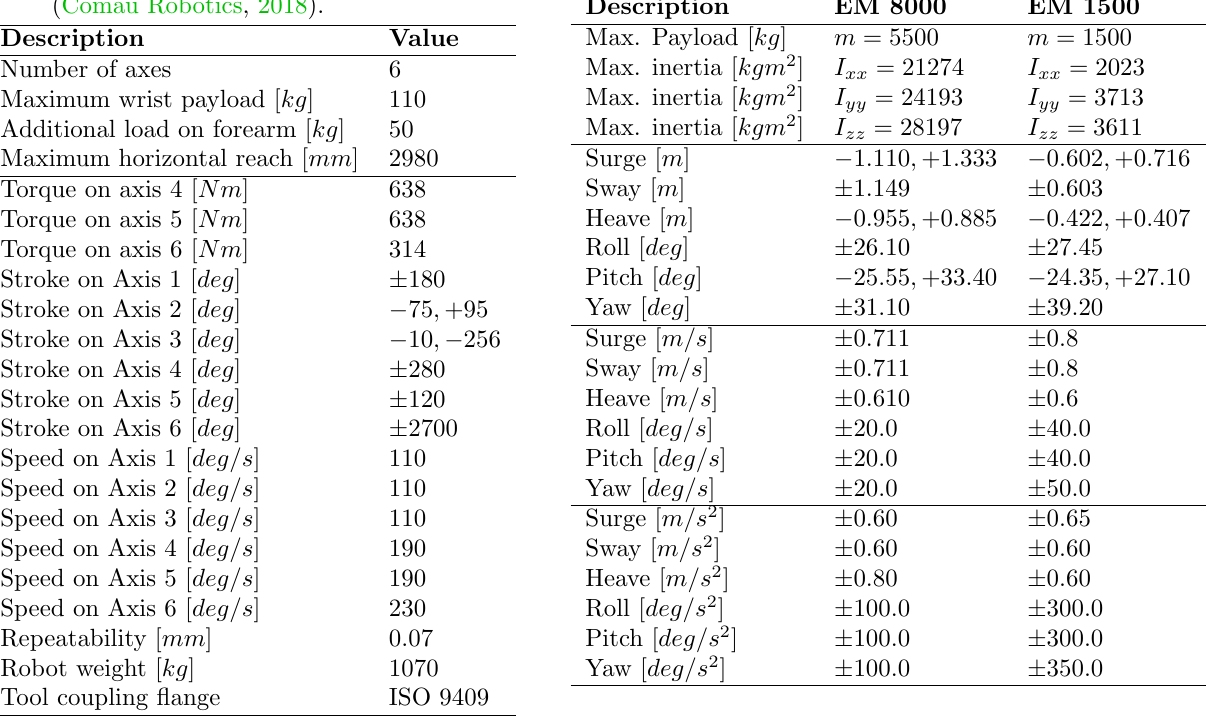
Table 8: Specification and Capacity for E-Motion 8000 and E-Motion 1500 (Norwegian Motion Lab- oratory, 2018).